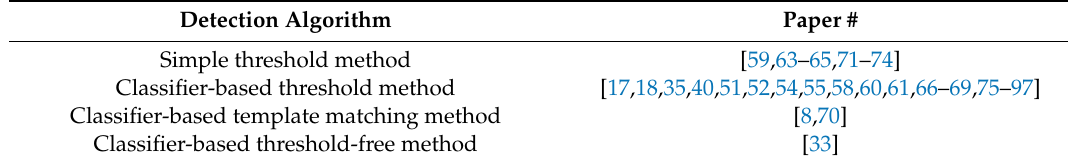
Table 2. Detection algorithms used in